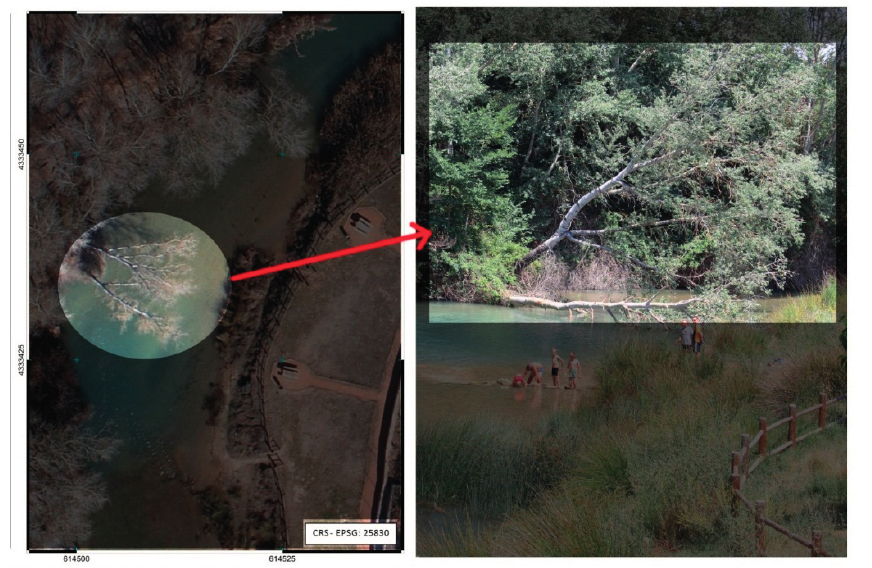
Figure 7. LWD detected in the orthoimage and the tree before its